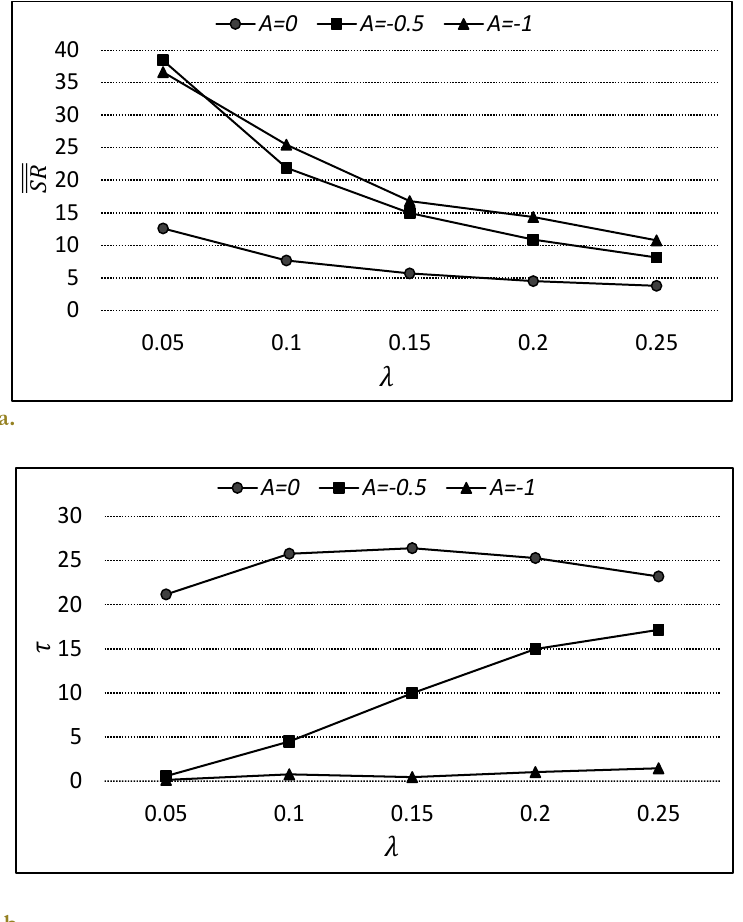
Fig. 2. Signal resistance study results for; a. 𝐒𝐑̅̅̅̅̅̅ , b. 𝛕 for various combinations of 𝐀 and 𝛌